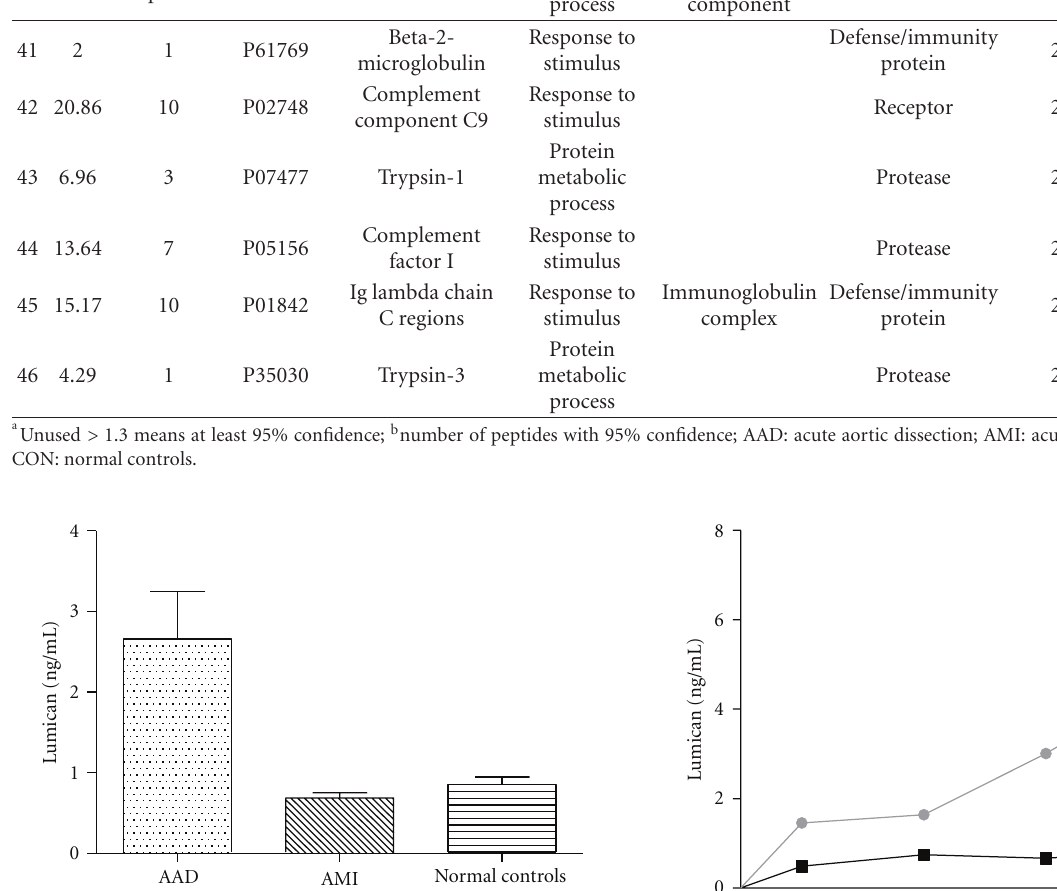
Figure 1: Lumican levels were significant di ff erence between AAD, AMI, and normal individuals (Mean ± SEM; P = 0 . 003).